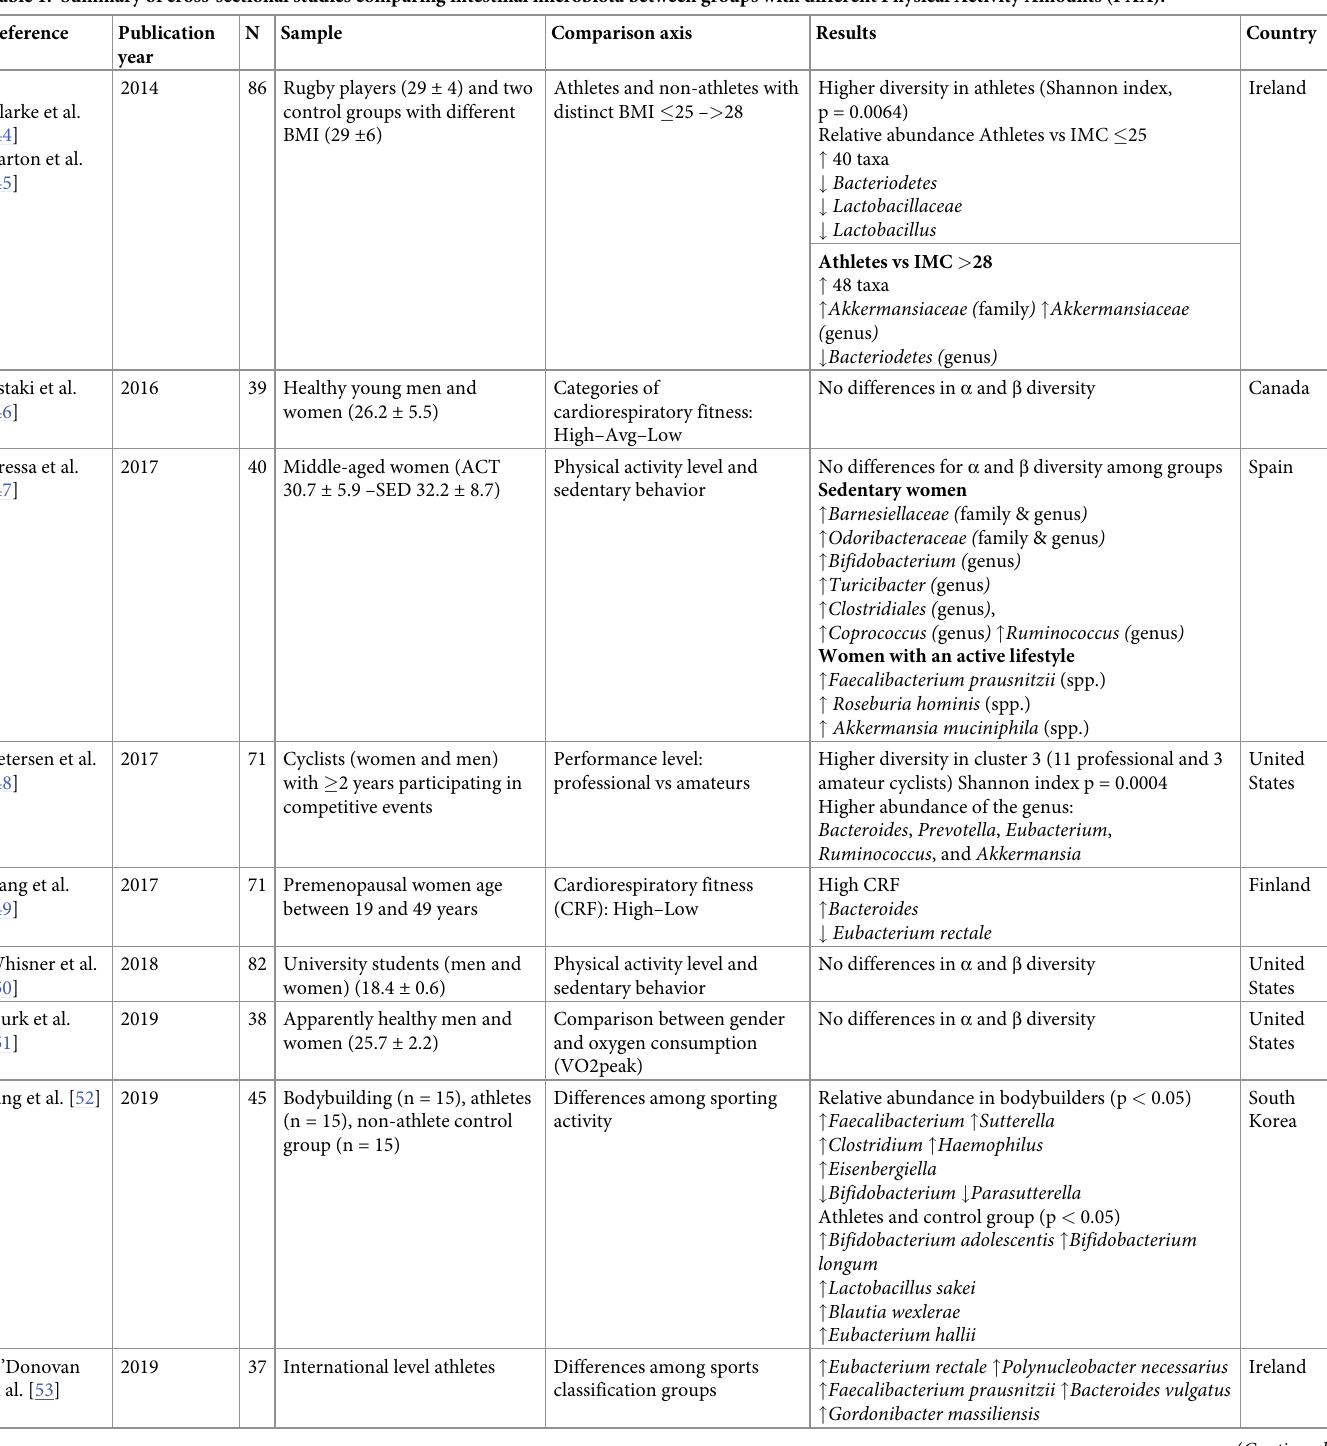
Table 1. Summary of cross-sectional studies comparing intestinal microbiota between groups with different Physical Activity Amounts